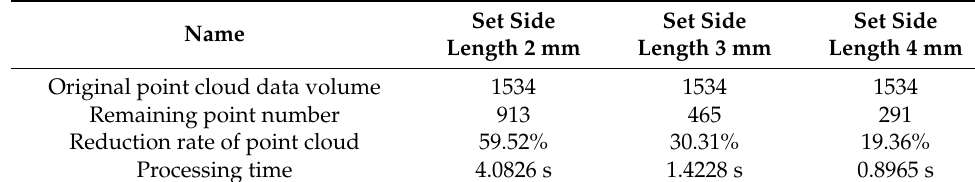
Figure 7. Different simplification effects under the bounding box with different side lengths. Table 1. Simplified result indicators under different side length bounding boxes.